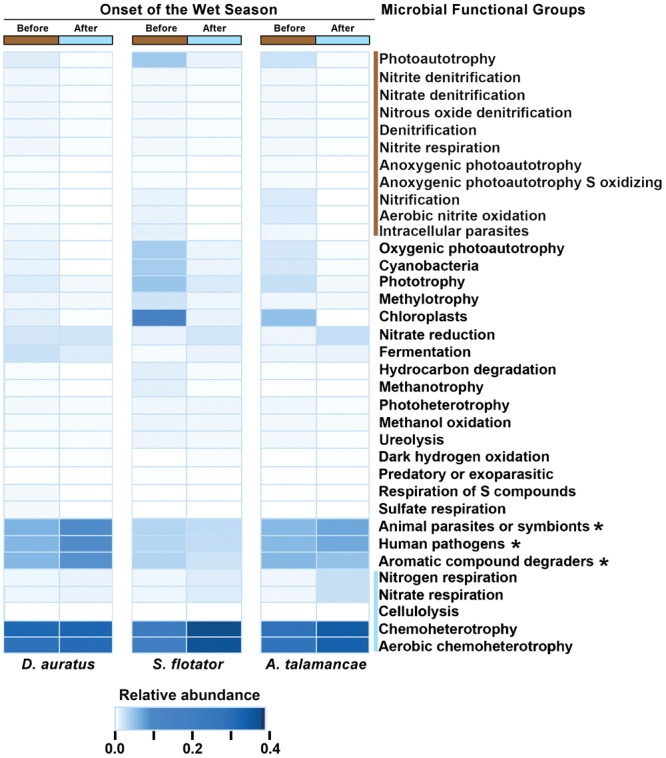
Mean relative abundances of skin microbial functional groups before and after the onset of the wet season in three species of dendrobatoid frogs, Dendrobates auratus, Silverstoneia flotator, and Allobates talamancae, from Pipeline Road, Panama. Relative abundances are depicted in terms of color intensity from white (=0) to darkest blue (=0.433). Microbial functional groups more abundant before the onset of the wet season are preceded by a brown bar, whereas groups more abundant after the onset of the wet season are preceded by a blue bar. Asterisks (∗) indicate microbial functional groups more abundant in D. auratus.